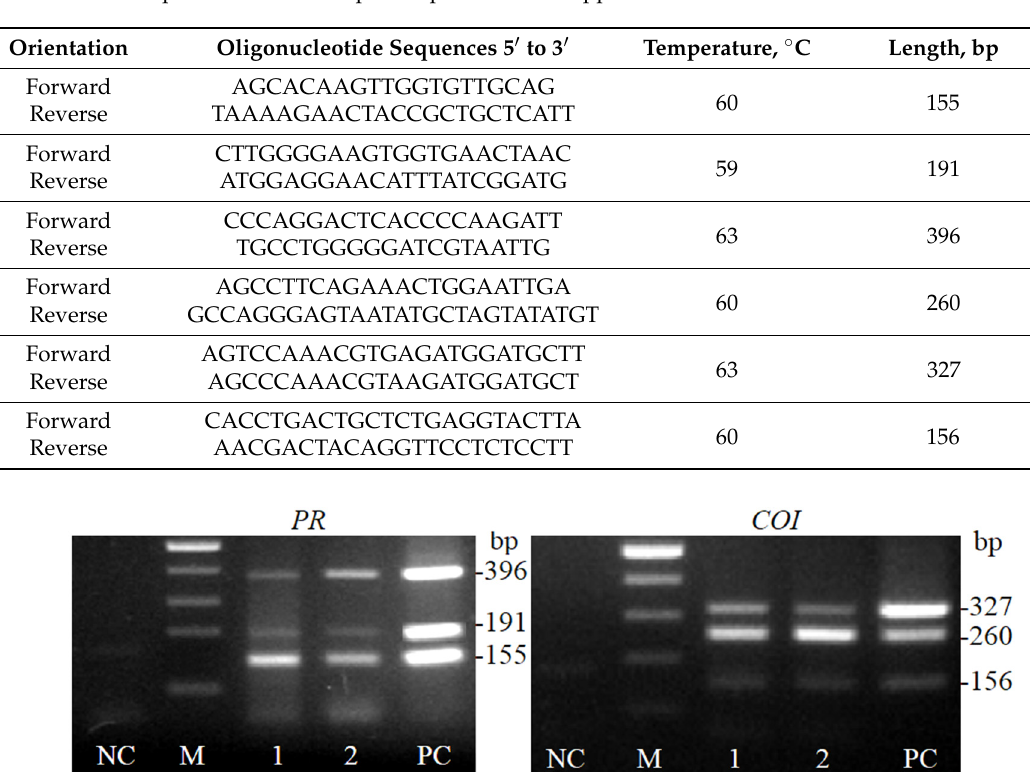
Table 2. Specific PR and COI primer pairs for Ribes spp.